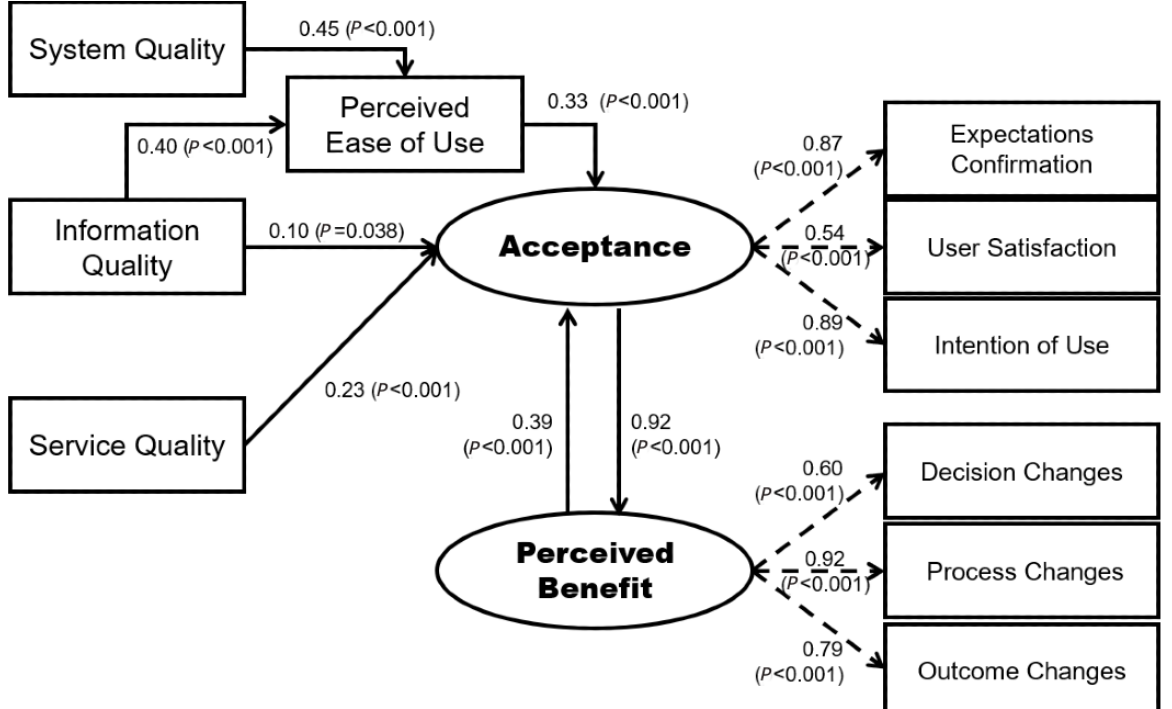
Figure 2. Final evaluation model (comparative fit index 0.991; goodness-of-fit index 0.957; root mean square error of approximation 0.052; standardized root mean square residual